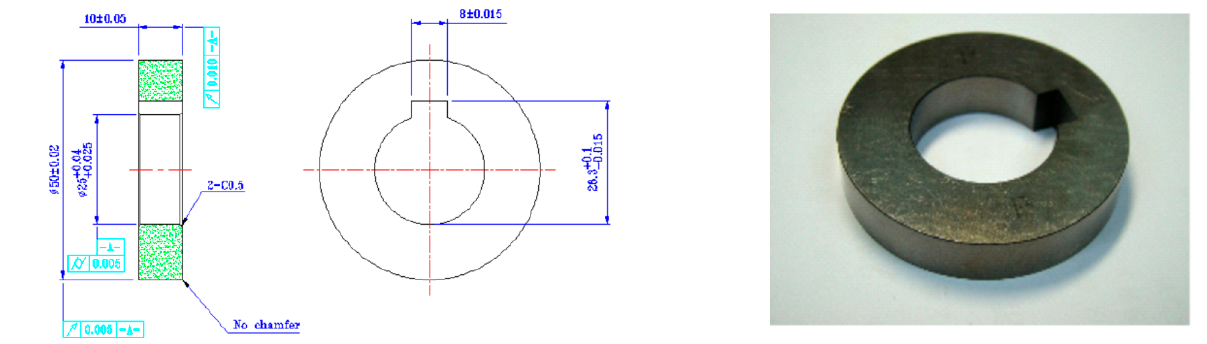
Figure 14. Location and orientation of the test specimen: ( a ) wheel; ( b ) rail.